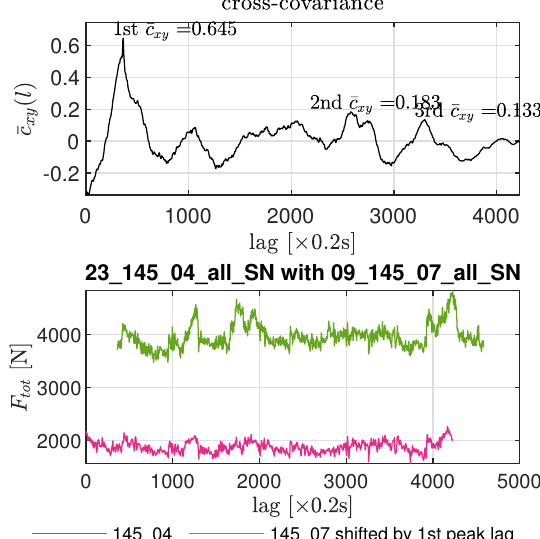
Figure 6: Upper plot normalised cross-correlation of loads on two different rollers indicating 1st to 3rd peak. Bottom plot signal over- laid with shifted signal by 1st peak’s lag.